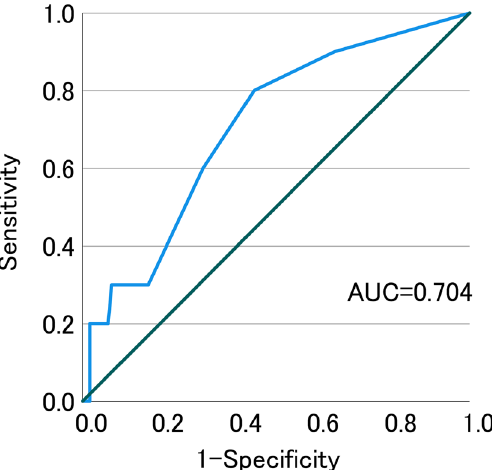
Figure 2. Prediction of the development of severe PSDs according to the CONUT score. AUC area under the